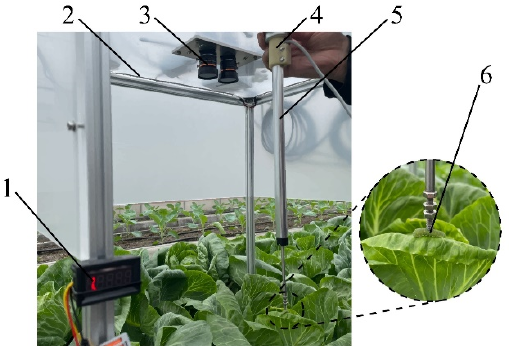
Figure 15. Accuracy testing experiment equipment. Key: 1. digital display for displacement sensor; 2. 850 nm diffuse light bar; 3. binocular camera with an 850 nm filter; 4. base with a magnet; 5. linear displacement sensor; 6. Pieris rapae .